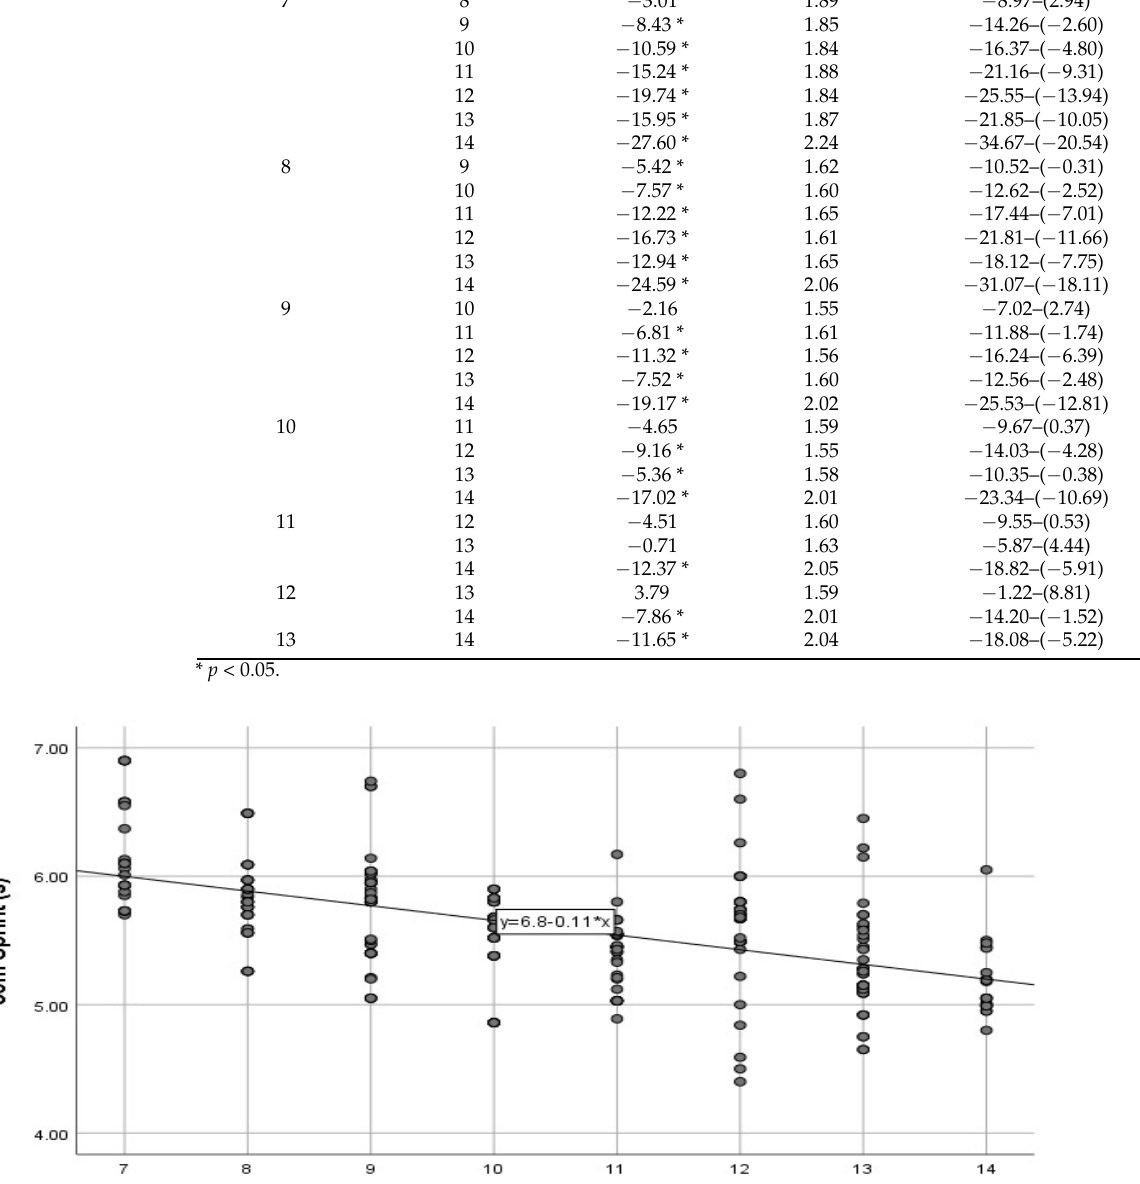
Figure 2. A scatter plot and the corresponding regression line for the relationship between the de- pendent variable, agility T-Test (s), and the independent variable chronological age (years.).